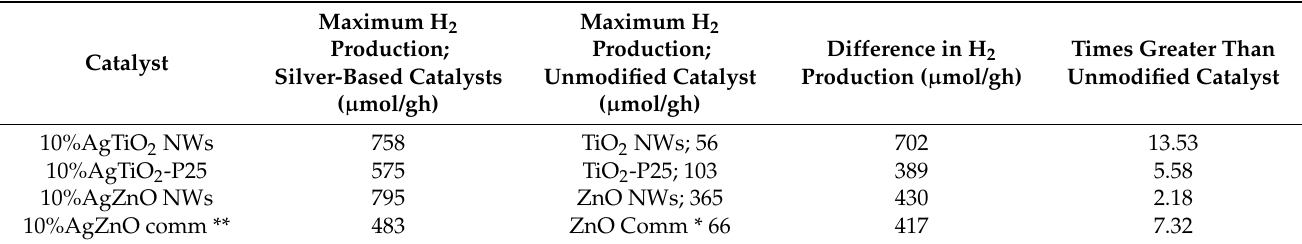
Table 2. Silver-based catalysts with the highest hydrogen production and their difference from the unmodified supports at a wavelength of 320 nm *.